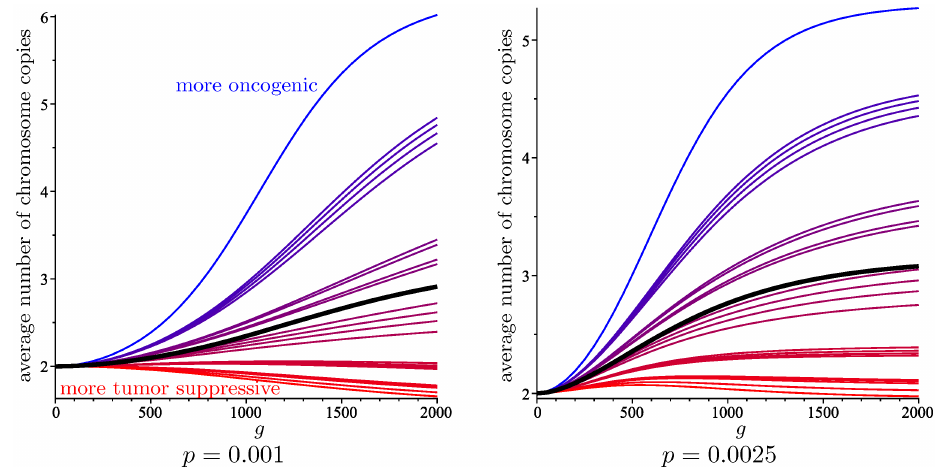
Fig 8. The evolution over 2000 generations of the average number of copies of the 23 human chromosomes, for N = 8 and two values of p . For each chromosome, the color of the curve depicts how oncogenic (blue) or tumor suppressive (red) it is. The average of the 23 averages is shown in black.